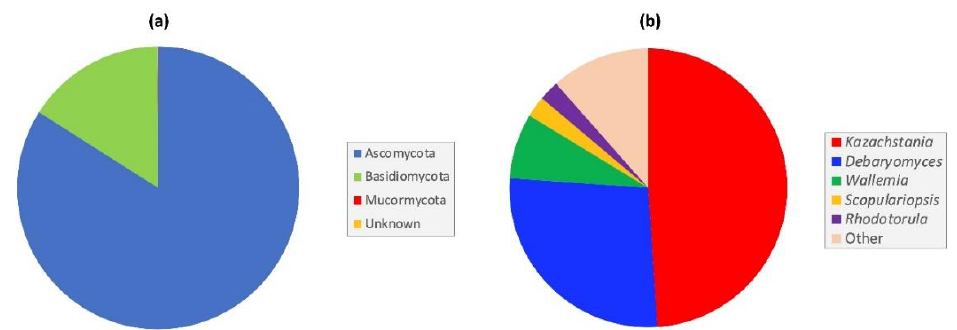
Figure 1. Most abundant fungi in the captive cynomolgus macaque GIT at ( a ) phylum, and ( b ) genus level.